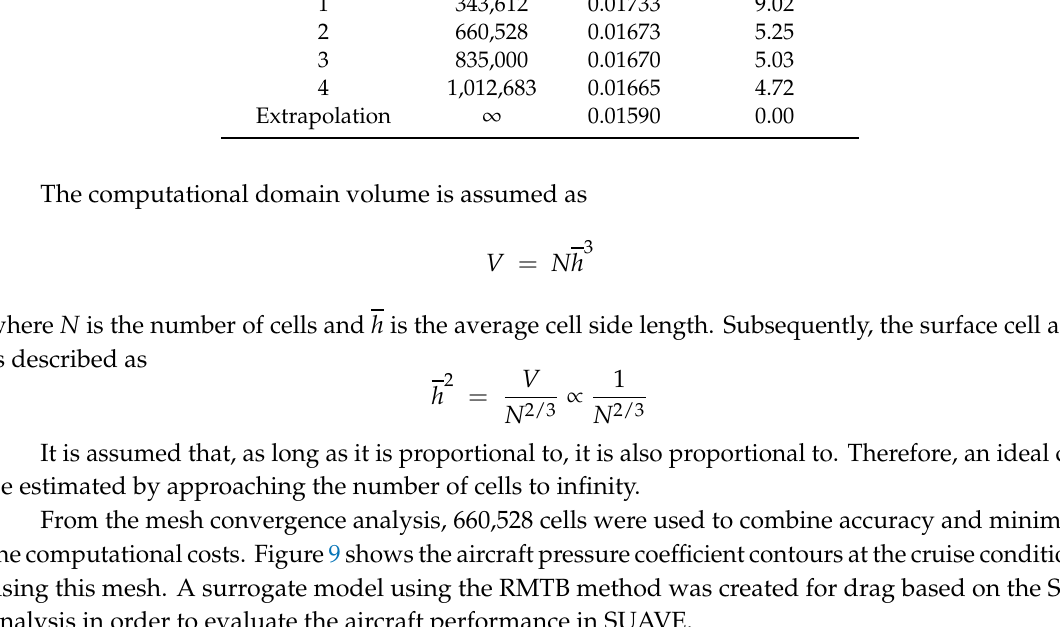
Figure 9. Pressure coefficient contours of lower (left) and upper (right) aircraft surfaces. ( (cid:2009) = 0°, M = 0.85).